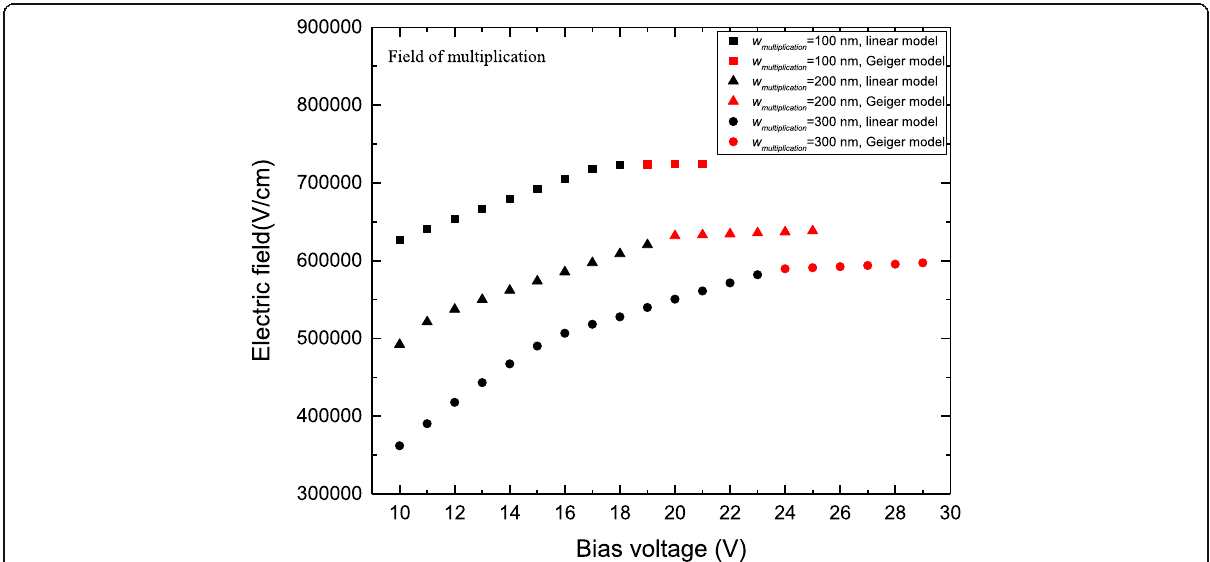
Fig. 4 Simulation results electric field in multiplication under the Geiger mode. The values of W multiplication is 100 nm (black square), 200 nm (black triangle), 300 nm (black circle). Figure 3 presents the simulated field-voltage characteristics in the multiplication layers under the Geiger mode. The thickness of the charge layer is 50 nm, and the thicknesses of the multiplication layer are 100, 200, and 300 nm, respectively